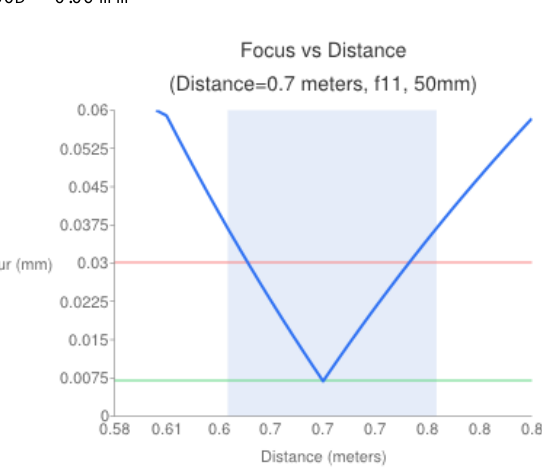
Fig. 3 Focus vs Distance chart for 5D Mark II